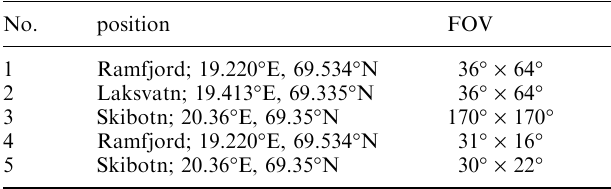
Table 1. Parameters of the cameras run near Tromsø. FOV is the field of view